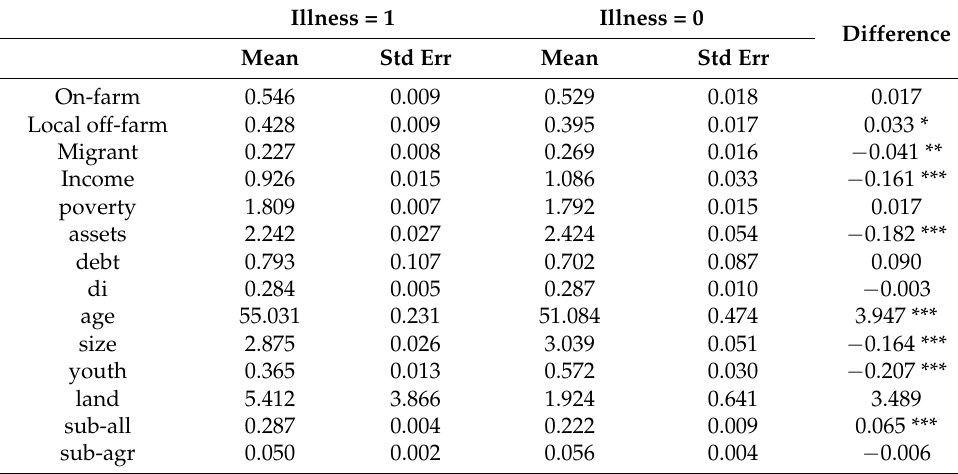
Table 2. Summary of variables by health